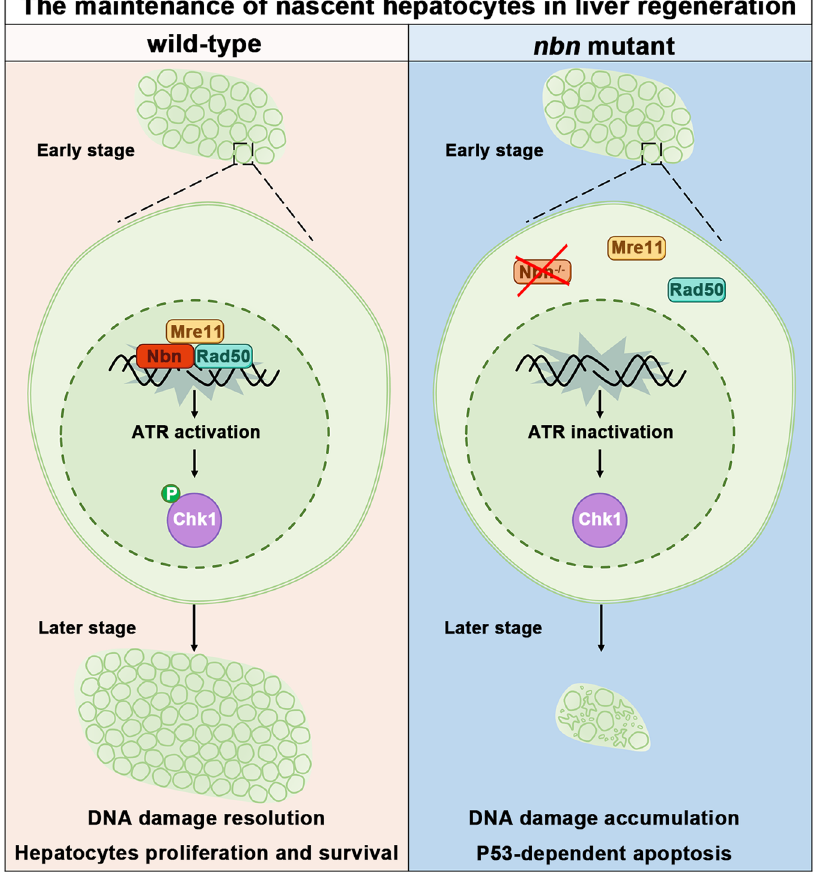
Fig. 7 The molecular mechanism model showing the MRN complex governs the survival of regenerating hepatocytes in the later stage of liver regeneration. During the highly proliferative phase of liver regeneration, the hepatocytes undergo endogenous DNA damage caused by replication stress. In normal livers, the MRN complex is recruited to DNA damage and activates ATM and ATR, subsequently triggering an intricate signal transduction network called DNA damage response. Activated cell cycle checkpoints arrest cell cycle progression and allow DNA repair so regenerated hepatocytes can survive and proliferate. In nbn mutant, the truncated Nbn mislocalizes in the cytoplasm, and the MRN complex cannot be recruited to the DNA damage site. The ATR-Chk1 signaling is prevented from activation. The stalled replication fork may collapse and trigger p53-dependent apoptosis, ultimately leading to defective liver regeneration. lines in this study. Embryos were treated with 0.003% 1-phenyl-2- thiourea (PTU, Sigma-Aldrich) to inhibit pigment formation. Larvae were anesthetized in 0.16 g/L tricaine (Sigma-Aldrich) prior to experiments.